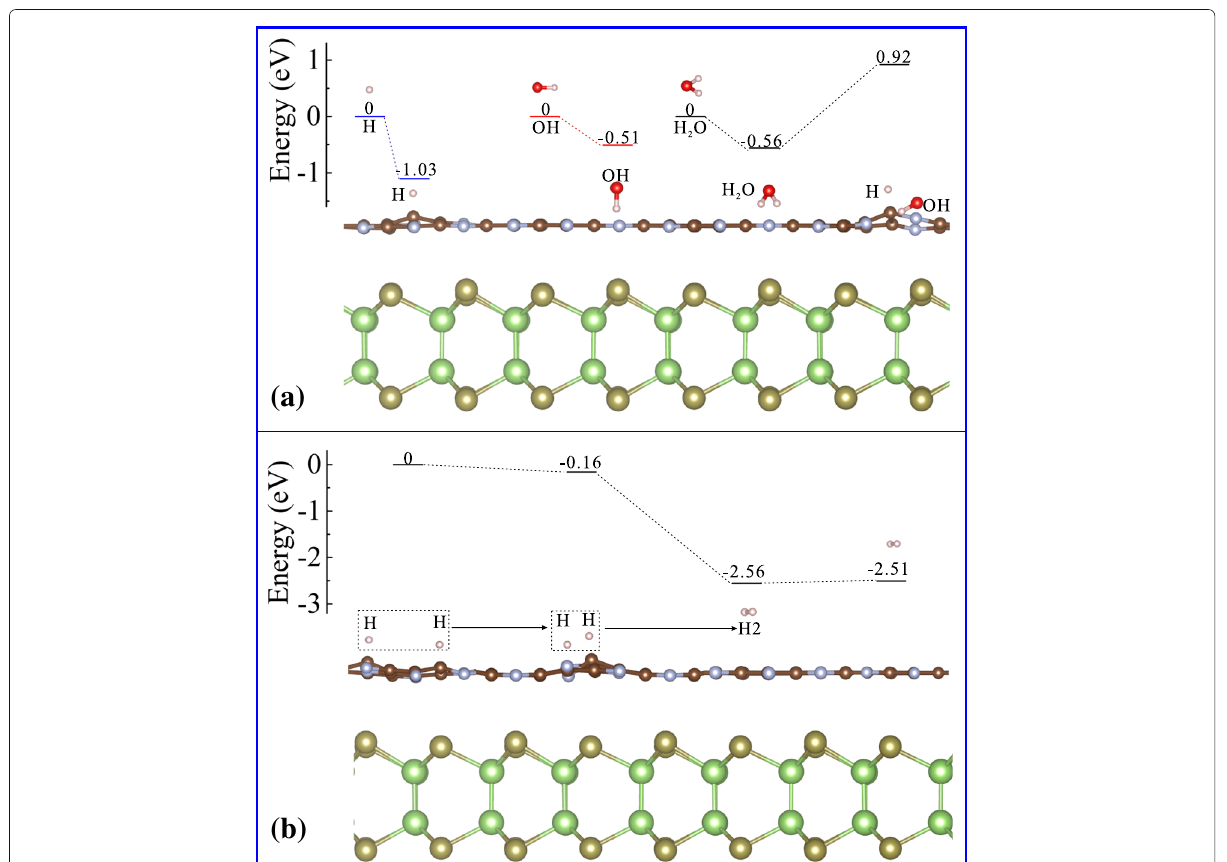
Fig. 5 a Adsorption configurations of H, OH, H 2 O and decomposition mechanism of H 2 O on C 2 N surface in GaTe/C 2 N vdW heterostructure. b Interaction between two hydrogen adatoms, formation and releasing of hydrogen molecular on C 2 N surface in GaTe/C 2 N vdW